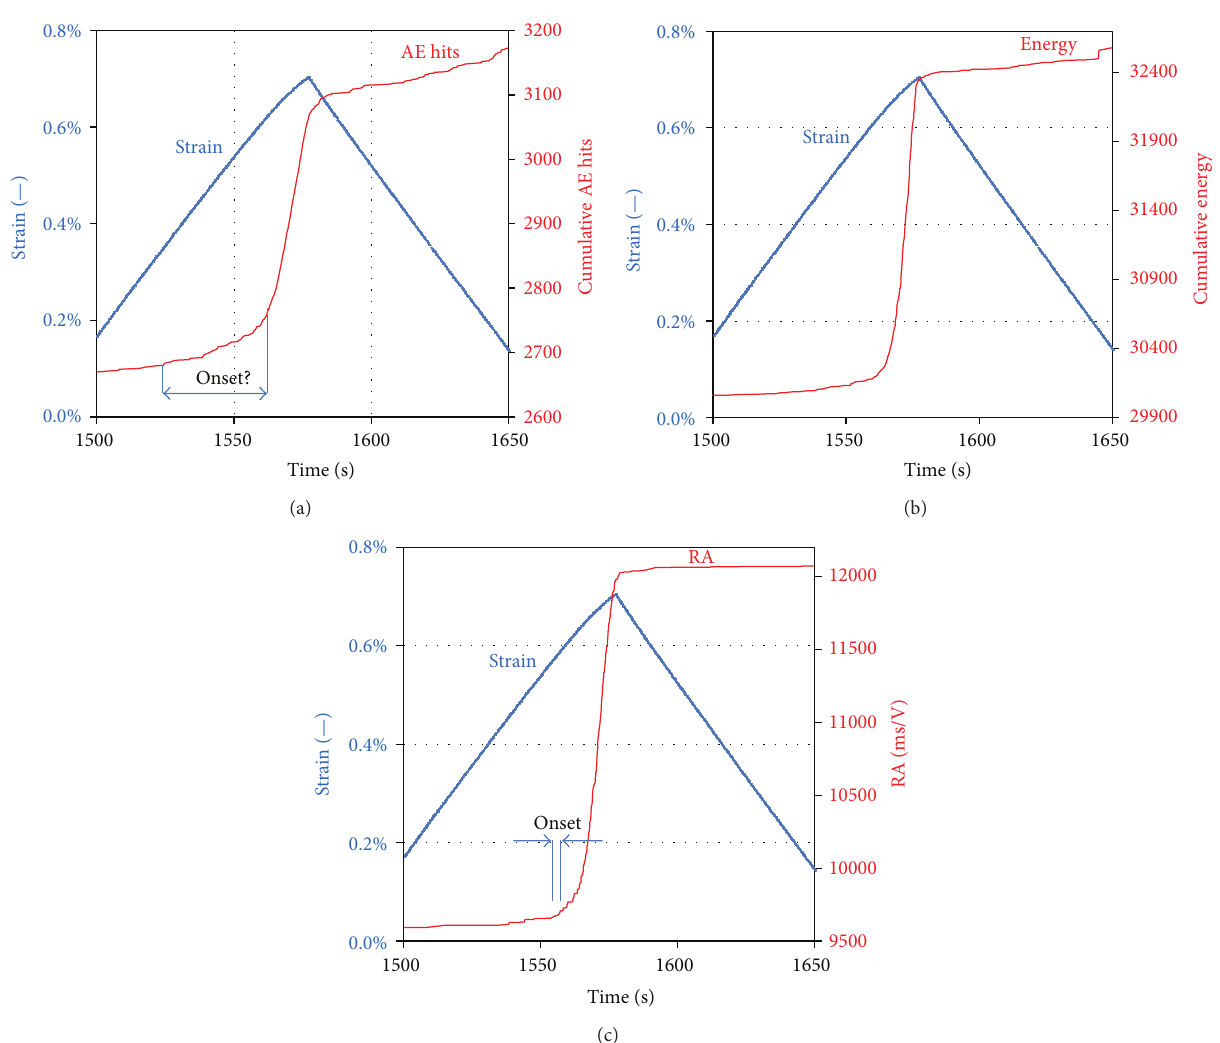
Figure 6: Strain and cumulative (a) AE hit, (b) AE energy, and (c) RA values for the 15th cycle of specimen C.